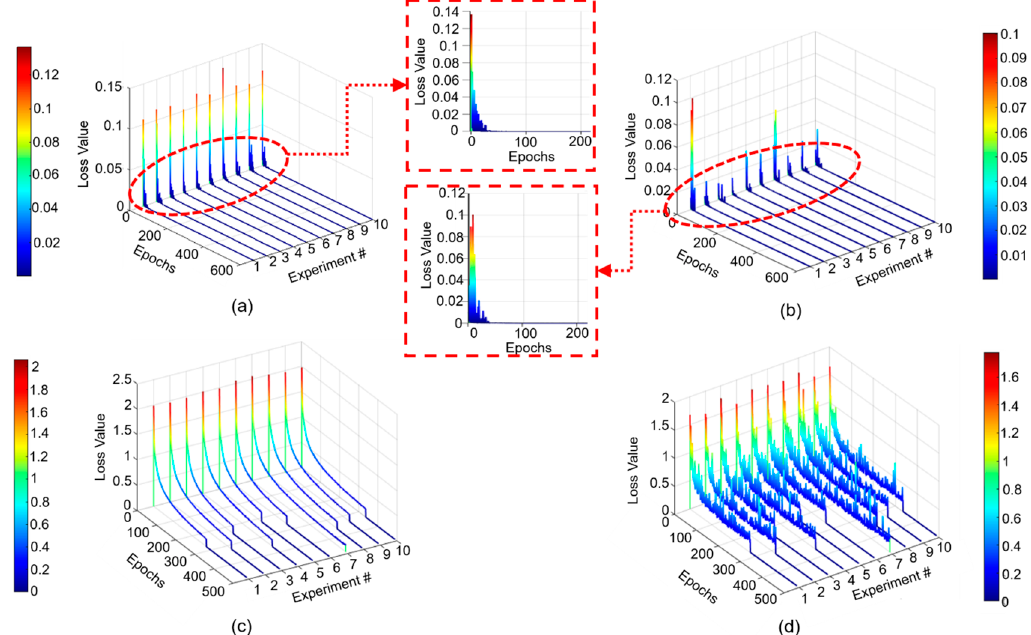
Figure 5. The training and validation loss curves obtained during ten experimental trials by the proposed technique: ( a ) training loss curves of DUDAE, ( b ) validation loss curves of DUDAE, ( c ) training loss curves of DNN, and ( d ) validation loss curves of DNN, respectively.